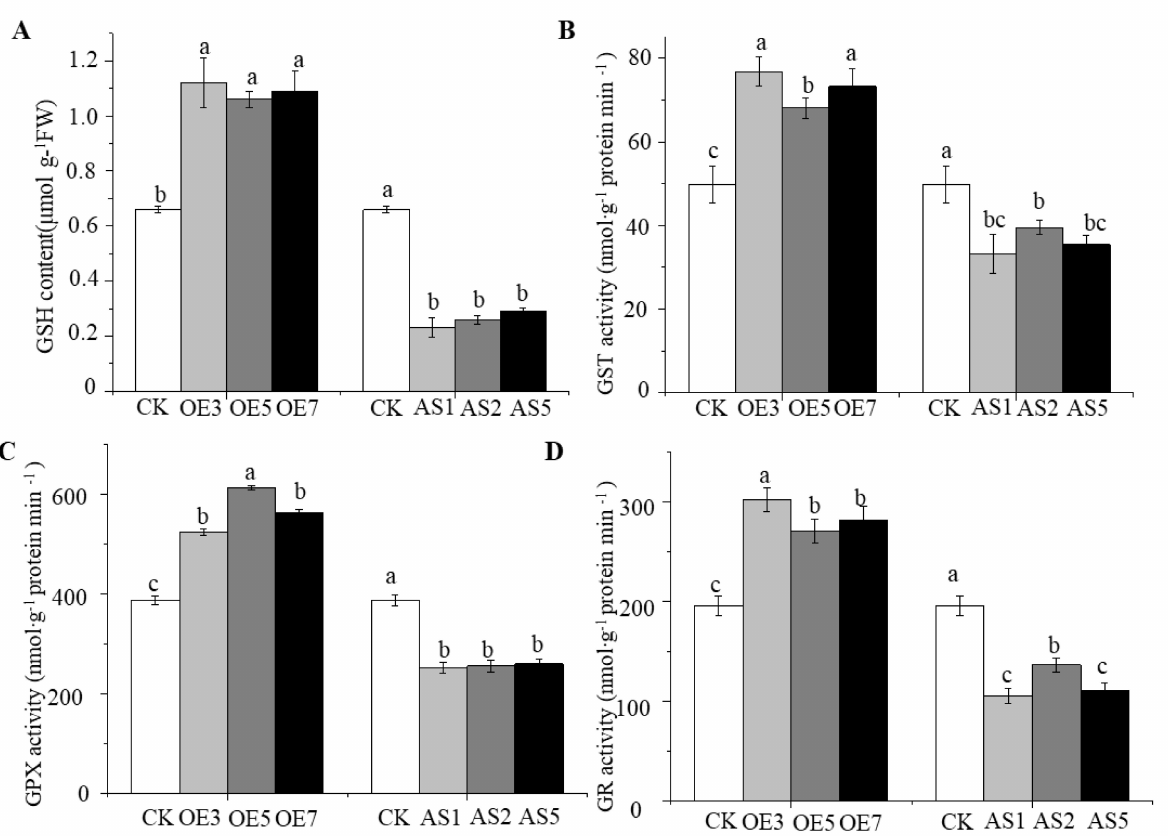
Figure 6. Content of glutathione (GSH) and activities of enzymes of the glutathione pathway in the leaves of the control, CsGSH2- overexpressing (OX), and antisense (AS) plants at 48 h after propamo- carb application. ( A ) GSH content. ( B ) Glutathione S-transferase (GST) activity. ( C ) Glutathione peroxidase (GPX) activity. ( D ) Glutathione reductase (GR) activity. Data are the means of three replicates with SEs, and different letters indicate significant differences ( p <